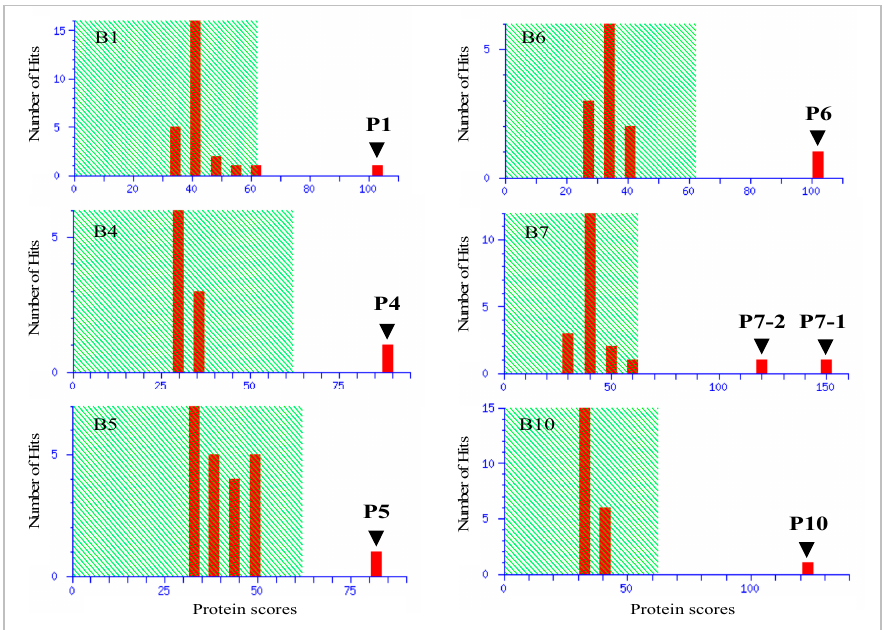
Figure 4. Histograms of identified protein components by mass spectrometry. The results of score histograms of six proteins (B1, B4, B5, B6, B7, and B10) were successfully obtained by mass spectrometry (MALDI-TOF) of 11 proteins (B1–B11). Seven components (P1, P4, P5, P6, P7-1, P7-2, and P10) were identified (Table 3) via the NCBI database. Protein scores > 67 are significant. Table 3. Identification of protein components via the NCBI database. Band Sample